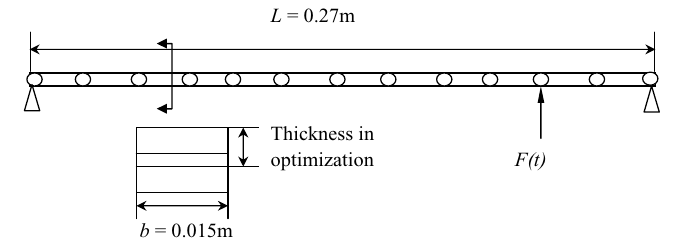
Fig. 7. Schematic of sandwich beam finite element model for the numerical study.